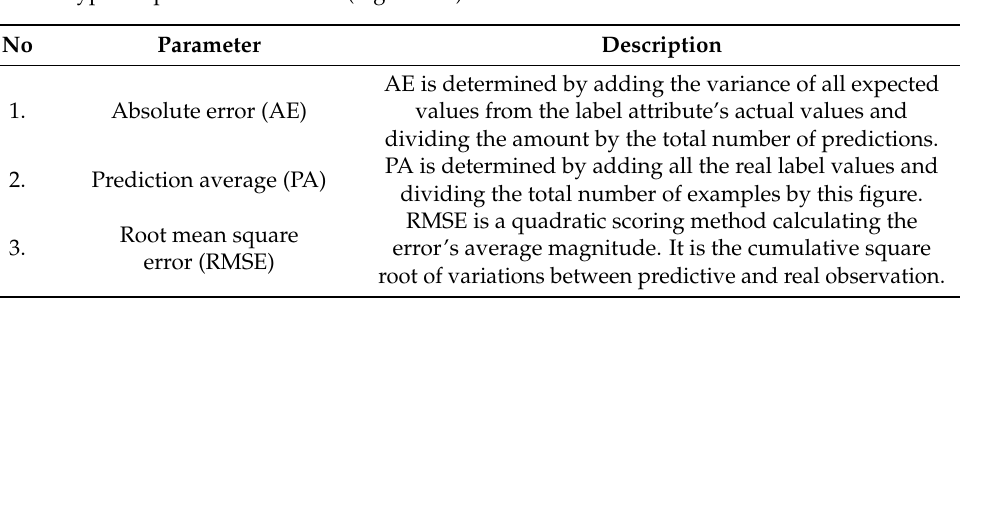
Table 5. Types of performance index (regression) used for SVM—dot